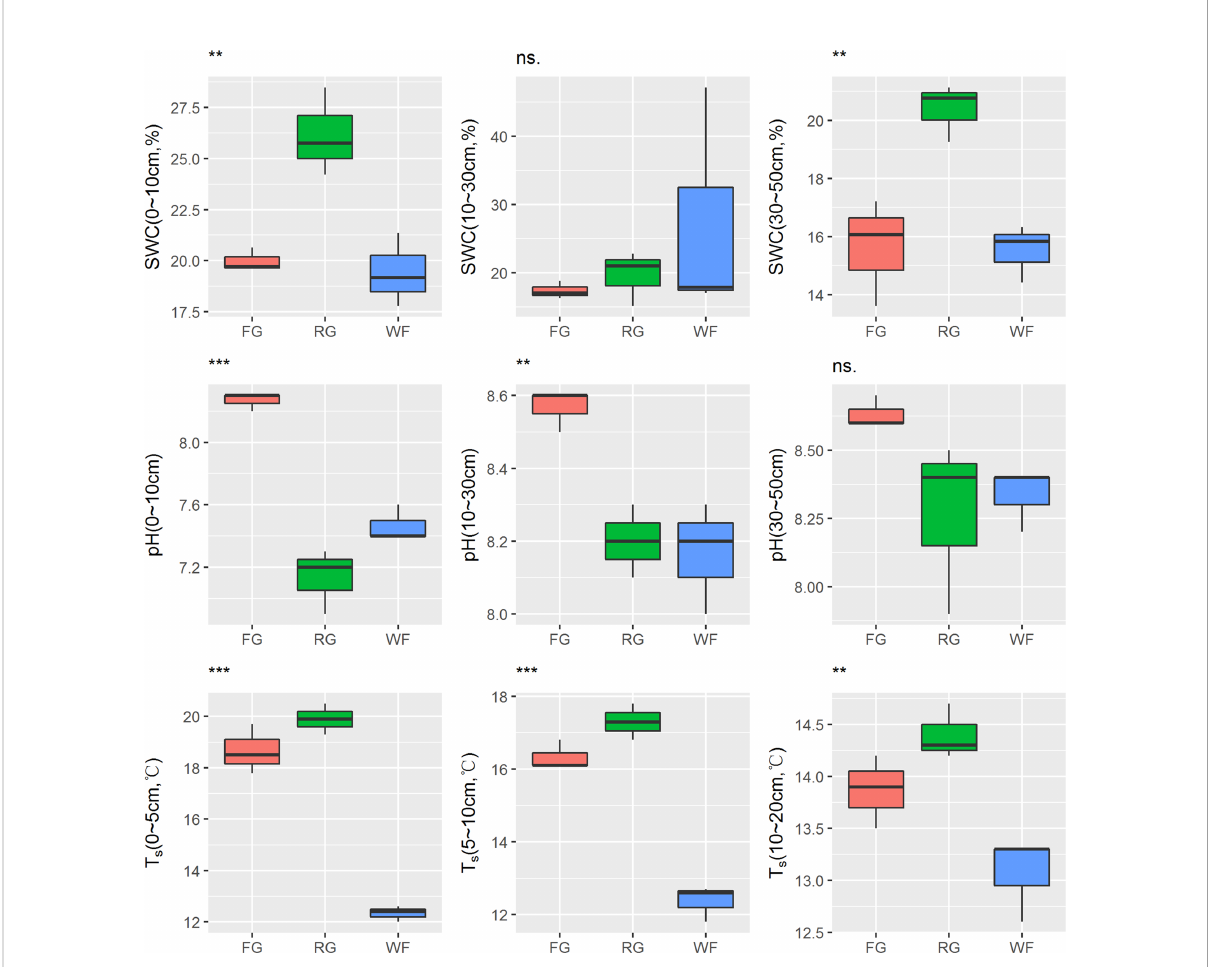
FIGURE 4 Effects of different grassland managements on soil water content (SWC), pH and soil temperature (Ts) at Maqin alpine meadow. FG: free grazing, RG: arti fi cial grass planting, WF: enclosure; “ *** ” , “ ** ” and “ ns. ” represent signi fi cant relationship of P < 0.001, P < 0.01 and P > 0.05,